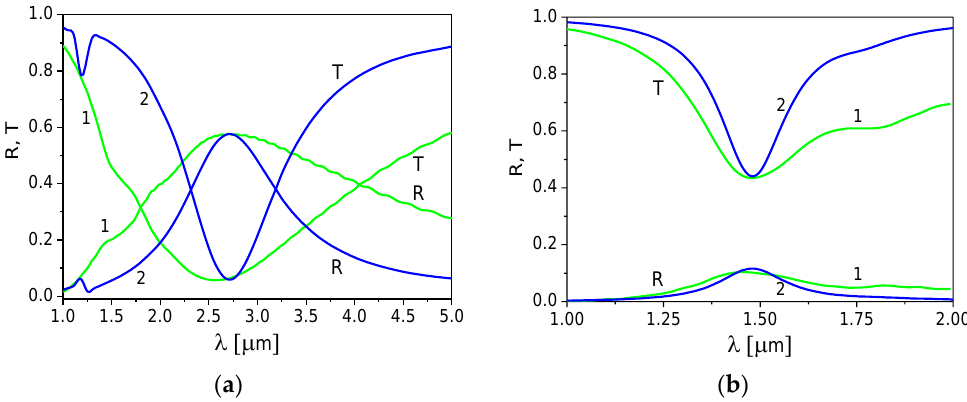
Figure 5. Reflection and transmission spectra of the ITO nanoribbon grating with a grating spacing Λ = 300 nm and a ribbon aspect ratio ( a ) d / Λ = 0.25 and ( b ) d / Λ = 0.75 calculated using COMSOL software for an ITO grating with a thickness h = 120 nm (curves 1) and using an approximation of the infinitely thin grating (curves 2). Parameters used for the approximation of the infinitely thin grating: ( a ) τ = 8 fs and n 2 D = 3.1 × 10 19 m − 2 and ( b ) τ = 13.1 fs and n 2 D = 3.5 × 10 19 m − 2 .